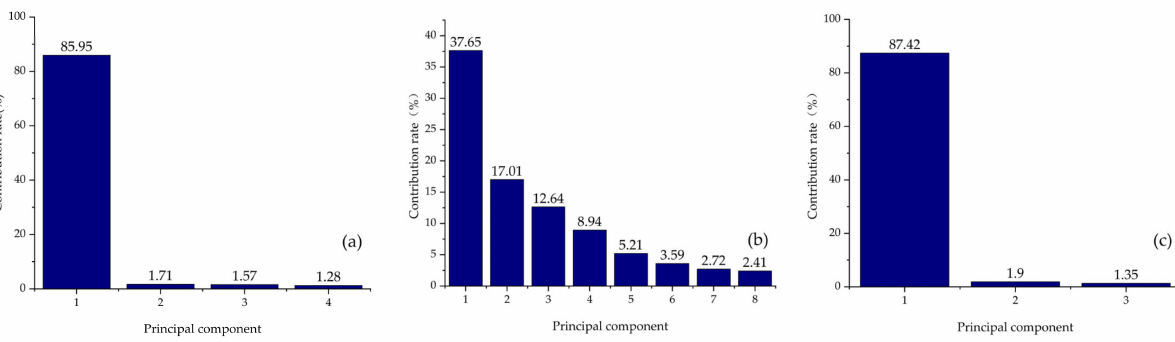
Figure 4. ( a ) First-order derivative spectra of parallel polarization reflection; ( b ) polarization reflection spectra processed by wavelet denoising.